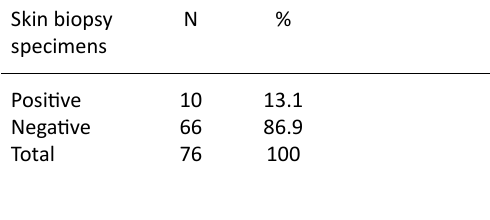
table 1. Confirmed Cutaneous TB positive cases